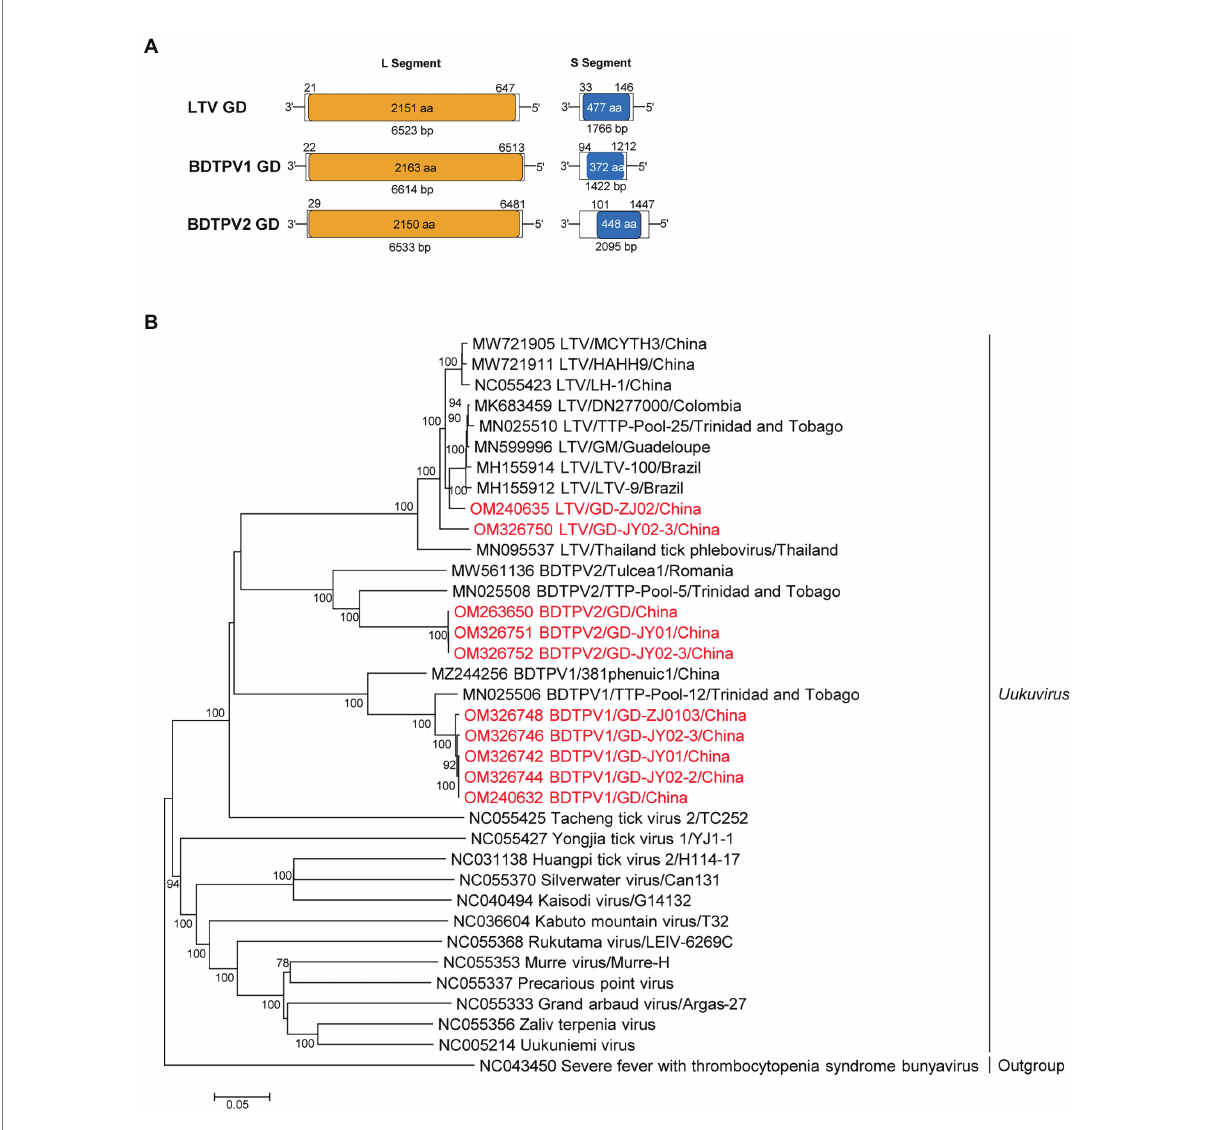
FIGURE 1 The genome characterization and phylogenetic analysis of uukuviruses. (A) Genome organization and putative coding regions of Lihan tick virus (LTV), Brown dog tick phlebovirus 1 (BDTPV1) and 2 (BDTPV2). The viral genome includes L and S segments that contained the predicted RNA depended RNA polymerase (RdRp) and nucleoprotein (NP) respectively. (B) Phylogenetic analyses of uukuviruses. Phylogenetic trees were constructed based on the L segment nucleotide sequences of representative viruses in the genus Uukuvirus . Viruses obtained in ticks here are highlighted in red. Scale bar indicates nucleotide substitutions per